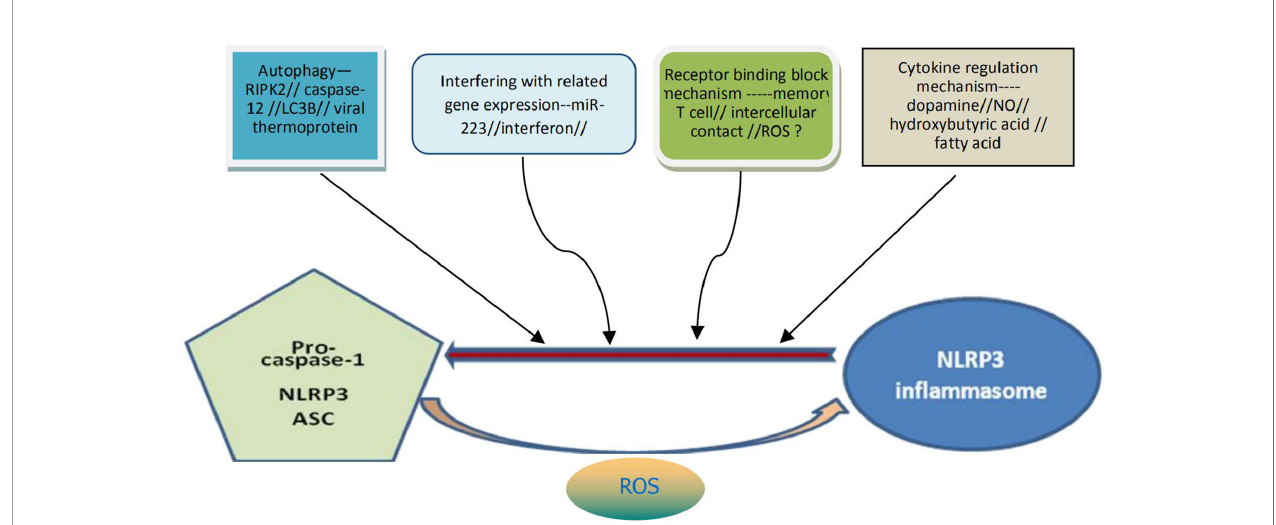
FIGURE 2 | Possible speci fi c mechanisms for negative regulation of NLRP3 in fl ammasome activation. The activation of NLRP3 in fl ammasome can be negatively regulated through at least four pathways: the mechanism of autophagy, the mechanism by interfering with the related genes expression, the mechanism of receptor binding and blocking, the mechanism from cytokine regulation. It can also be understood that the above four pathways contribute to the decomposition and destruction of NLRP3 in fl ammasome. ROS may be dual and generally contribute to the formation and activation of NLRP3 in fl ammasome. NLRP3, nucleotide- binding domain leucine-rich repeat and pyrin domain containing receptor protein 3; ROS, reactive oxygen